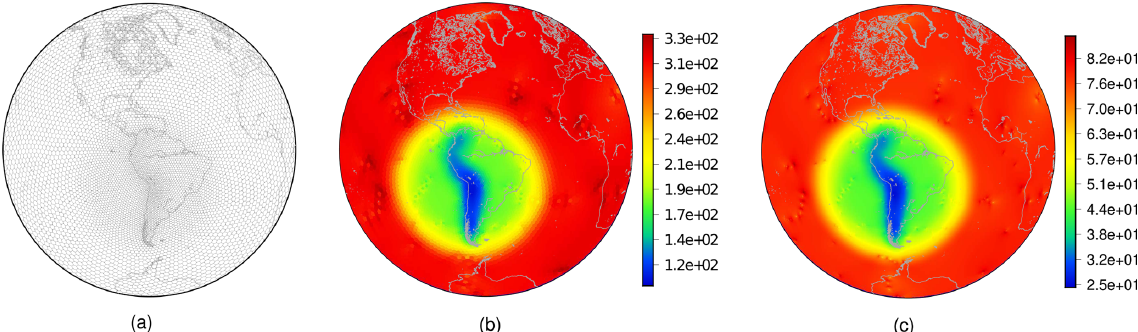
Figure 3. SCVT grid with local refinement on the Andes using 10242 generators (a) . Cell diameters in kilometers for the grid with (b) 10242 and (c) 163842 generators considering γ = 3, α = 7 π